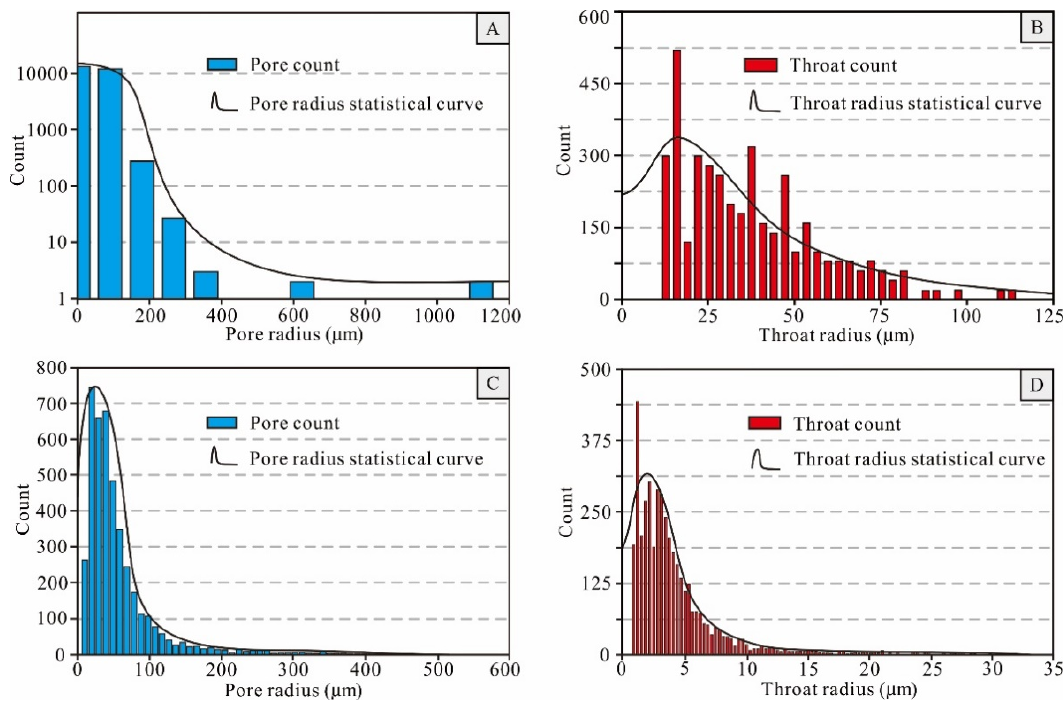
Figure 14. The radius distribution and count of the pores and throats of the Sample B' and Sample E'. ( A ) Sample B' pore radius; ( B ) Sample E' pore radius; ( C ) Sample B' throat radius; ( D ) Sample E' throat radius.